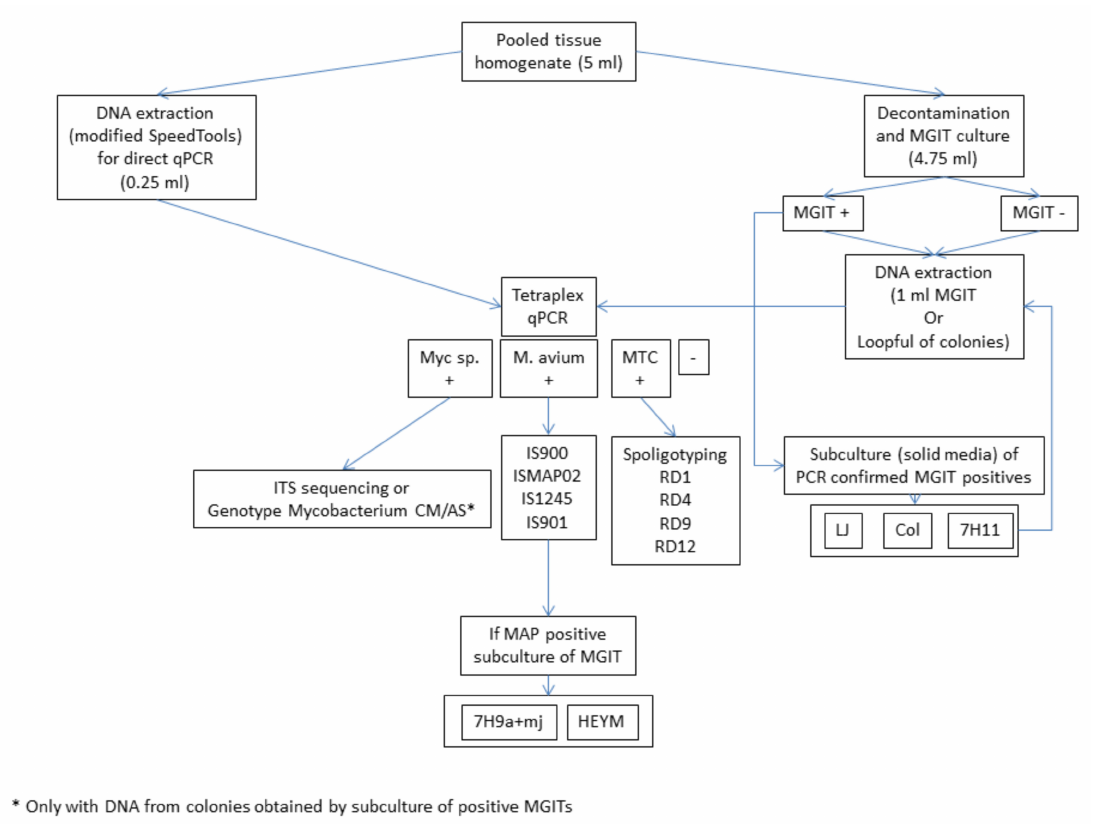
Figure 1. Schematic representation of the methodology. Culture media abbreviations: MGIT = Mycobacteria Growth Indicator Tube; LJ = Löwenstein–Jensen; Col = Coletsos; 7H11 = Middlebrook 7H11 supplemented with oleic acid-albumin-dextrose-catalase (OADC) enrichment; 7H9a + mj = agar-solidified 7H9 medium supplemented with OADC and mycobactin J; HEYM = in-house Herrold´s Egg Yolk medium containing sodium pyruvate and mycobactin J. + = positive result; - = negative